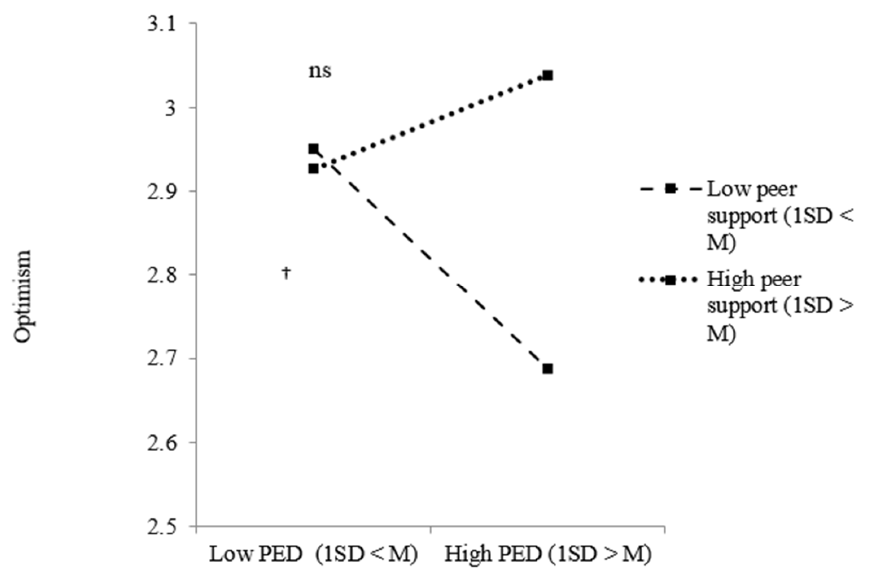
Figure 2. Effects of PED at school on ethnic-minority youth optimism dependent on the level of peer support. Note: † p < 0.10; ns = not significant.